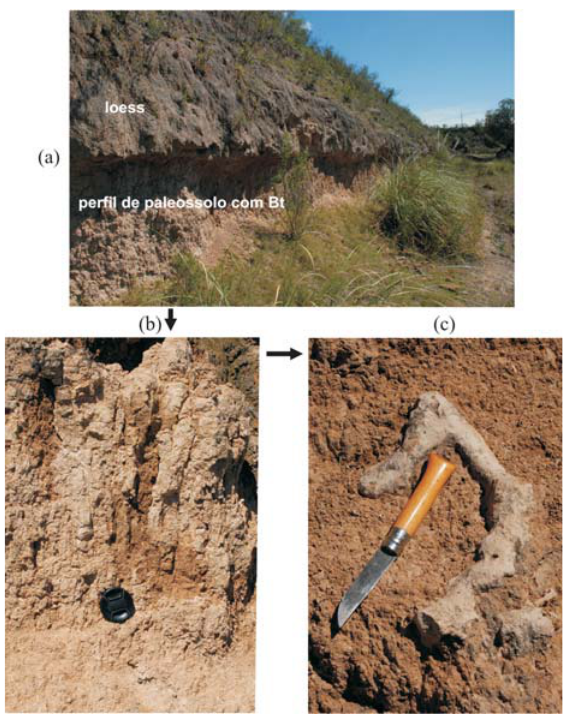
Figura 8. (a) Perfil de paleossolo (Pleistoceno) de- senvolvido a partir de depósitos de loess (La Plata, Argentina); (b) Detalhe do perfil do paleossolo; (c) Rizoconcreção de carbonato de cálcio.